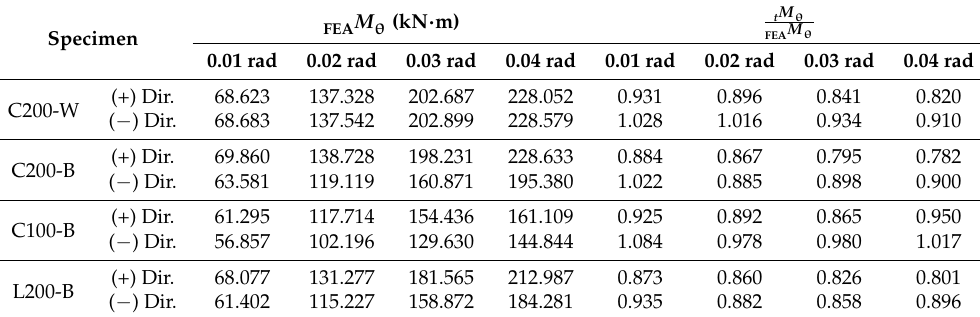
Table 8. Moment of the FE model (FEA).